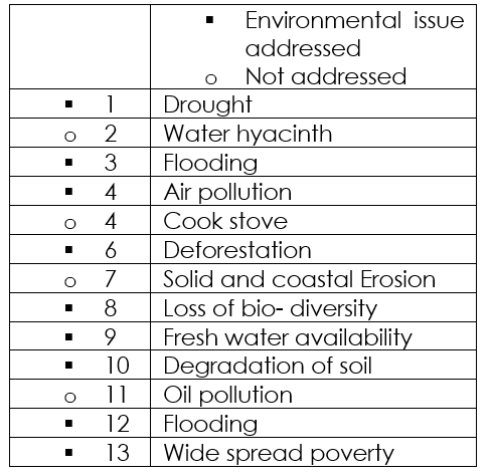
Table1: United Nations perspective.